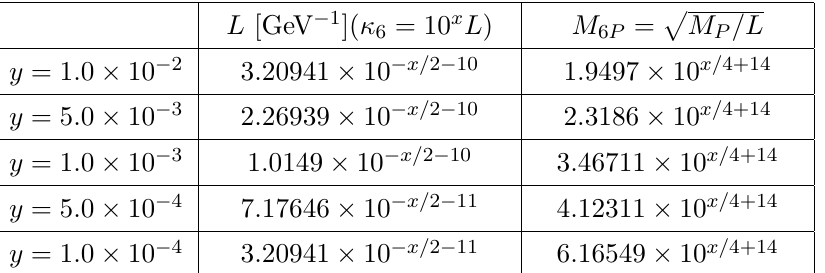
Figure 3 . Our results (table 2) in the n s - r plot from Planck 2018 data [14]. Orange circles are our results, where the small and large ones represent N ∗ = 50 and N ∗ = 60 , respectively.